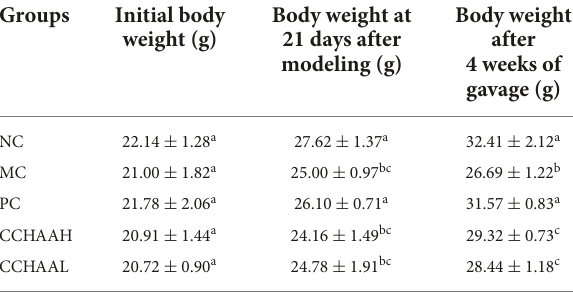
TABLE 1 Effects of several formulas on the body weight of mice.